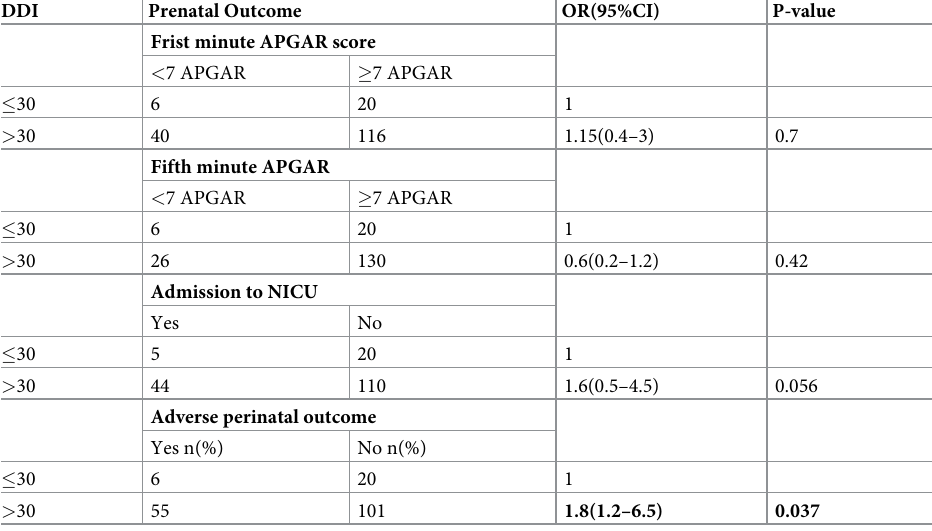
Table 5. Bivariate logistic regression analyses results: DDI vs. perinatal outcome in emergency cesarean section in Bahir Dar City Public Hospitals, Ethiopia,